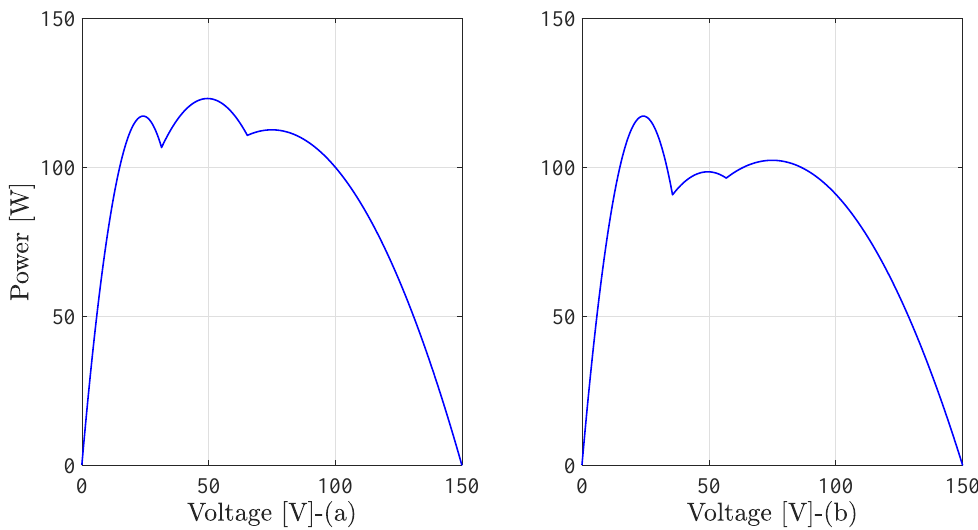
Figure 16. The characteristics of the PV emulator for more complex partial shading conditions: ( a ) The global peak is in the middle ( b ) The global peak occurs at